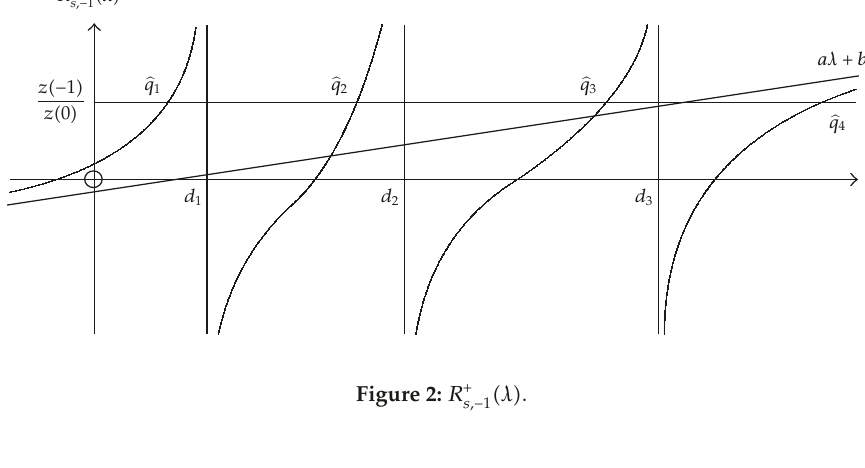
Figure 2: R (cid:8)